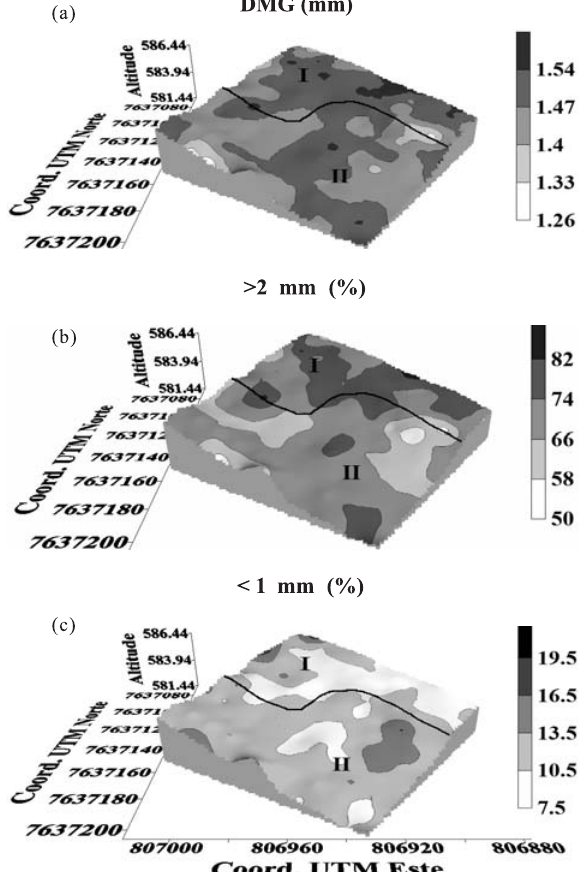
Figura 2. Mapas do padrão espacial do diâmetro médio geométrico (DMG) e das classes de agregados: > 2,0 e < 1,0